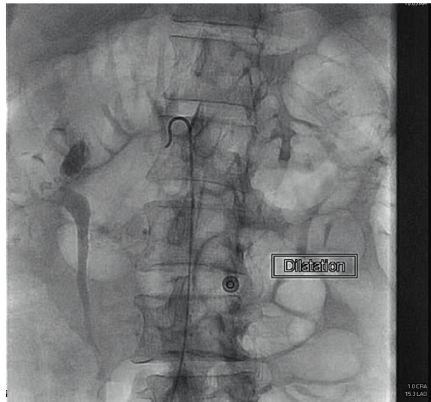
Figure 5: Dilatation evident during procedure.